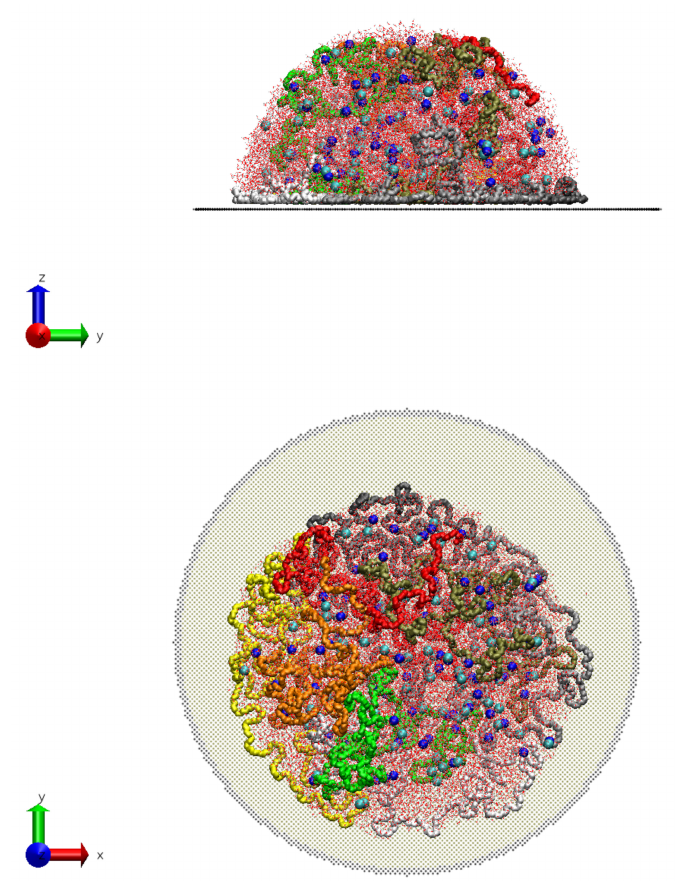
Figure 3. A droplet of polymer solution residing on the solid underlay before the electric field was applied (upper panel—side view, lower panel—top view). Composition of the particular system displayed is: 23,719 water molecules (O atoms red, H gray), eight 10.55-kDa poly(ethylene glycol) (PEG) chains (distinguished by different colors from one another), and 72 sodium chloride ion pairs (Na + —blue spheres, Cl − —cyan spheres). Graphics made by Visual Molecular Dynamics